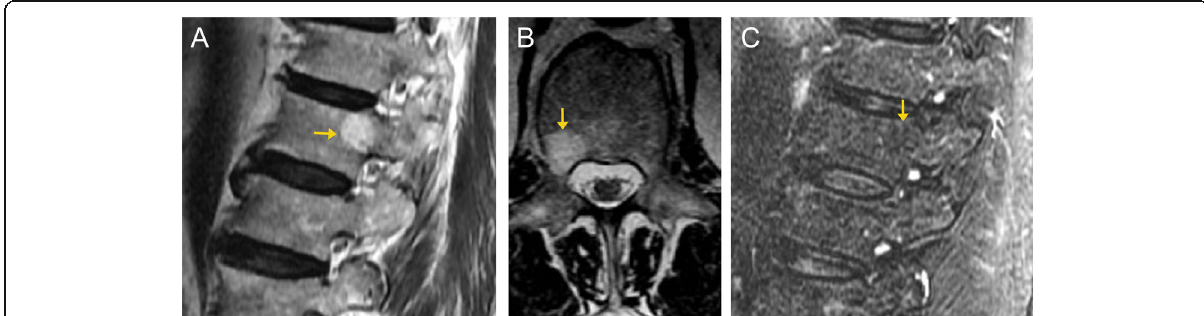
Fig. 3 Vertebral venous vascular malformation. Sagittal ( a ) and axial ( b ) T2-weighted MR images demonstrate a well-defined lesion in the right posterolateral aspect of T12 (arrows). The lesion is hyperintense relative to the surrounding normal marrow, and demonstrates suppression (arrow) on the T2 fat-suppressed sequence ( c ). This was an incidental finding and diagnosed radiographically as a vascular malformation. Given the lack of expansion into the spinal canal or compression of the cord, unlike the prior case, this is considered a “ do not touch ”